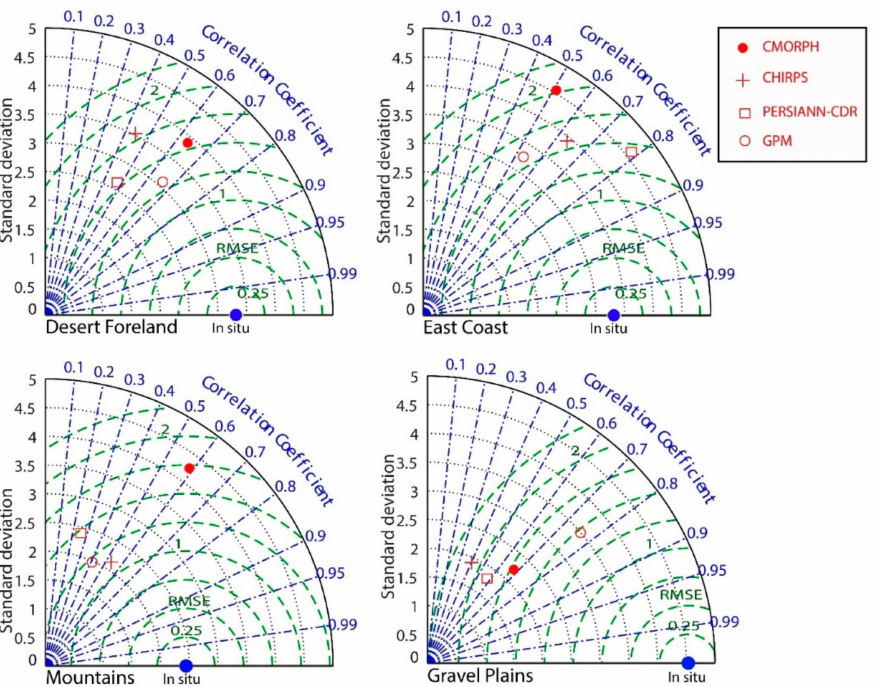
Figure 6. Taylor diagram depicting the performance of satellite products based on selected statistical measures over four climatological regions. The hollow circles represent the GPM-IMERG product while the solid circles represent the CMORPH product. Similarly, plus sign and hollow squares represent CHIRPS and PERSIANN-CDR,